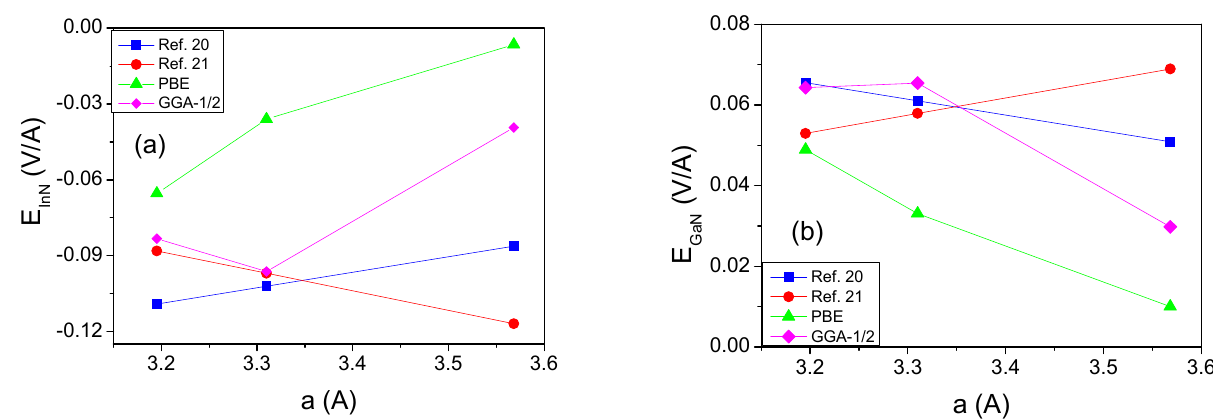
Figure 8. Electric fields in the well ( a ) and barrier ( b ) in 12GaN-6InN superlattice for various values of a lattice parameter a . The data denoted as refs. [20,21] were calculated using the values listed in Table 1 via Equation (3); the data denoted PBE and GGA-1/2 were obtained from ab-initio-derived double averaged electric potentials.